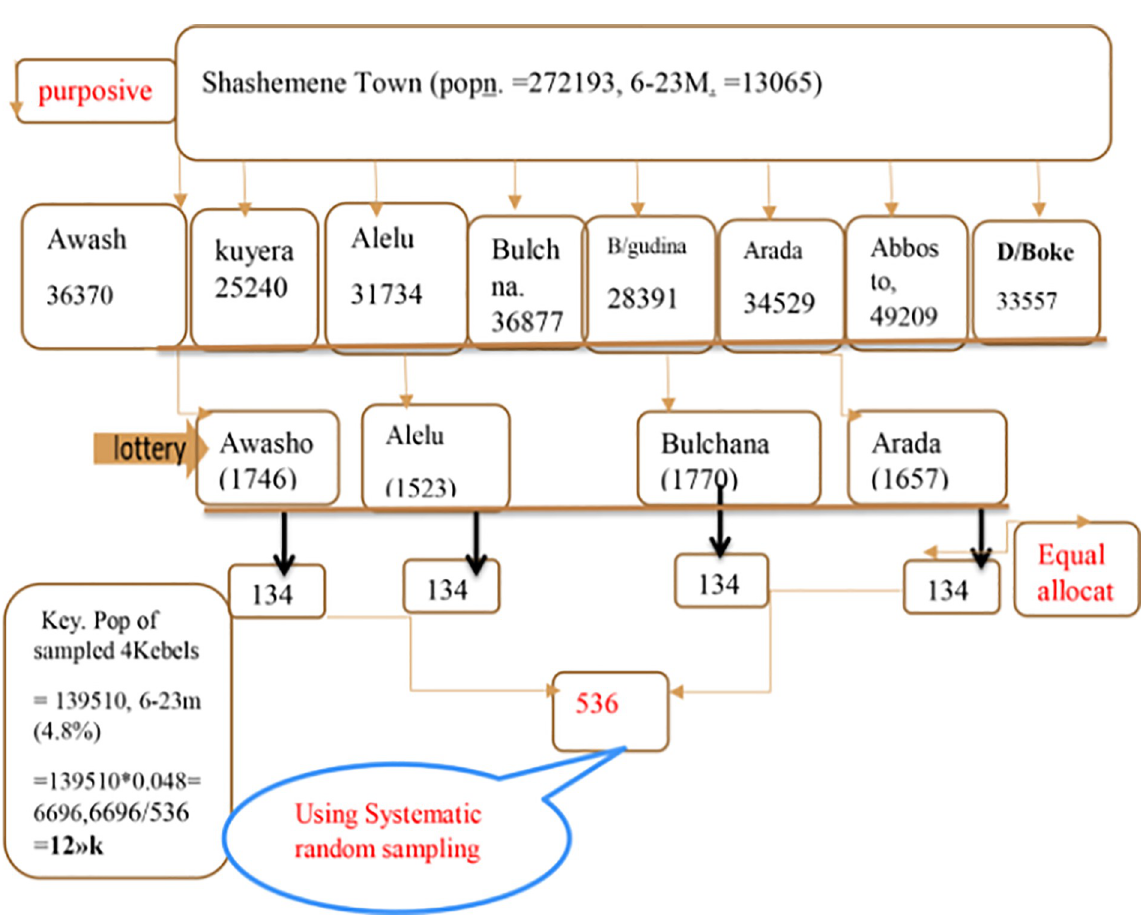
Fig 2. Diagrammatic presentation of sampling scheme of the sampled mothers-child pairs of 6–23 months age Shashamene, Ethiopia, 2020. D/Boke: Didaboke, pop(n): Population, B/gudina: Burka Gudina, m:month.